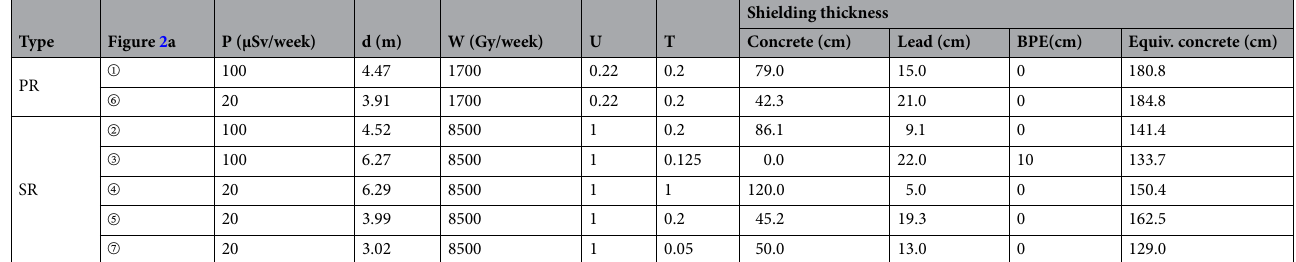
Table 3. Parameters and information for shielding walls according to each location. The numbers indicate measurement location shown in Fig. 6. PR primary radiation,* SR secondary